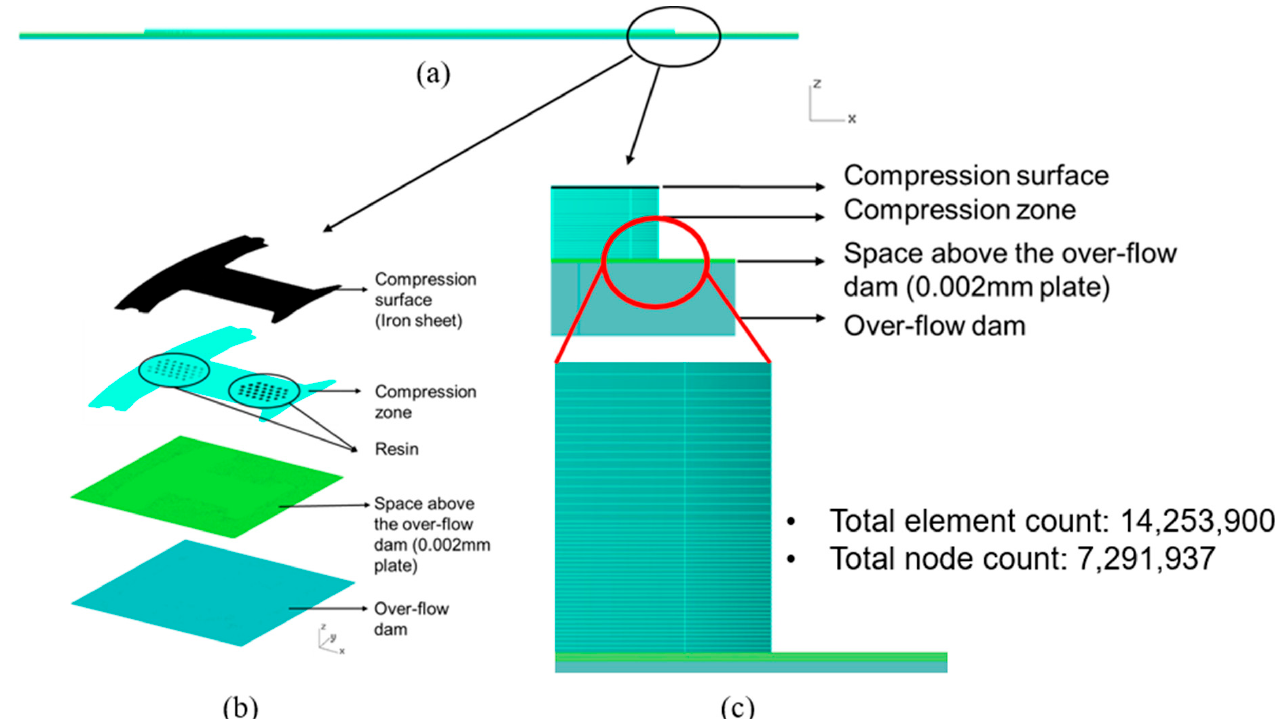
Figure 10. Mesh model used in the dipping process. ( a ) Side view of the overall mesh model used in the dipping process; ( b ) perspective view of the individual mesh model; and ( c ) illustration of partial enlargement of the mesh model used in the dipping process.